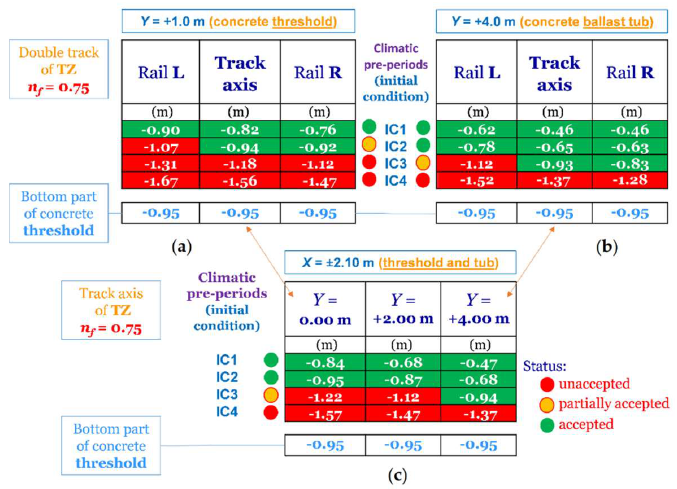
Buildings 2022 , 12 , x FOR PEER REVIEW 10 of 17 Figure 6. Results of experiments and analysis of freezing depths h : ( a ) iron-concrete threshold Y = +1.0 m; ( b ) concrete tub with ballast bed Y = +4.0 m; ( c ) threshold and tub X = ± 2.10 m.